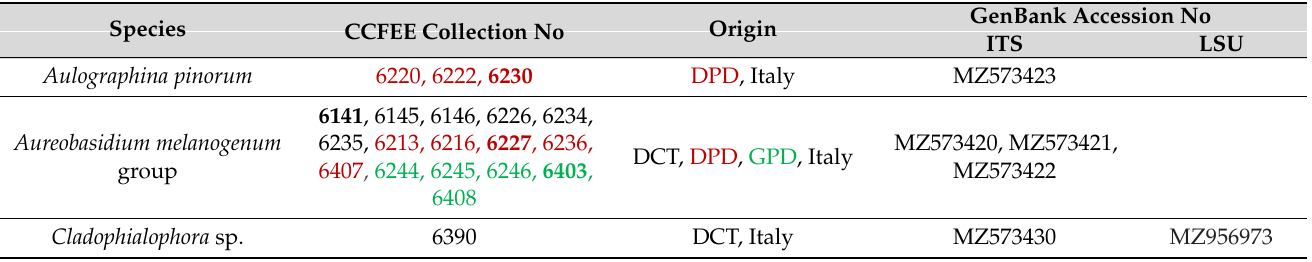
Cladophialophora sp.